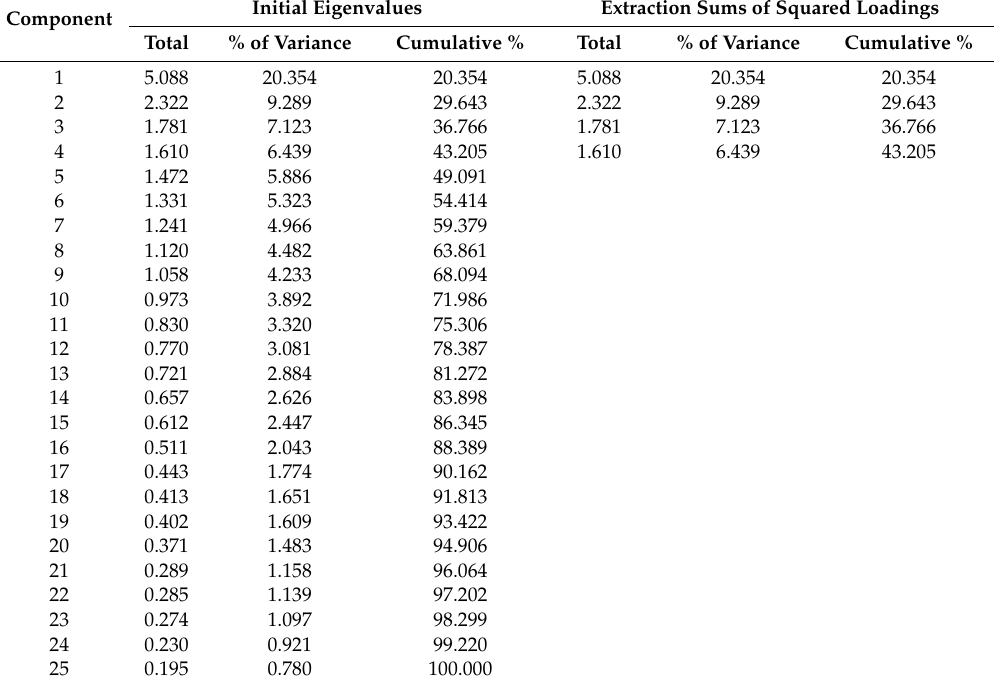
Table 3. Total explained